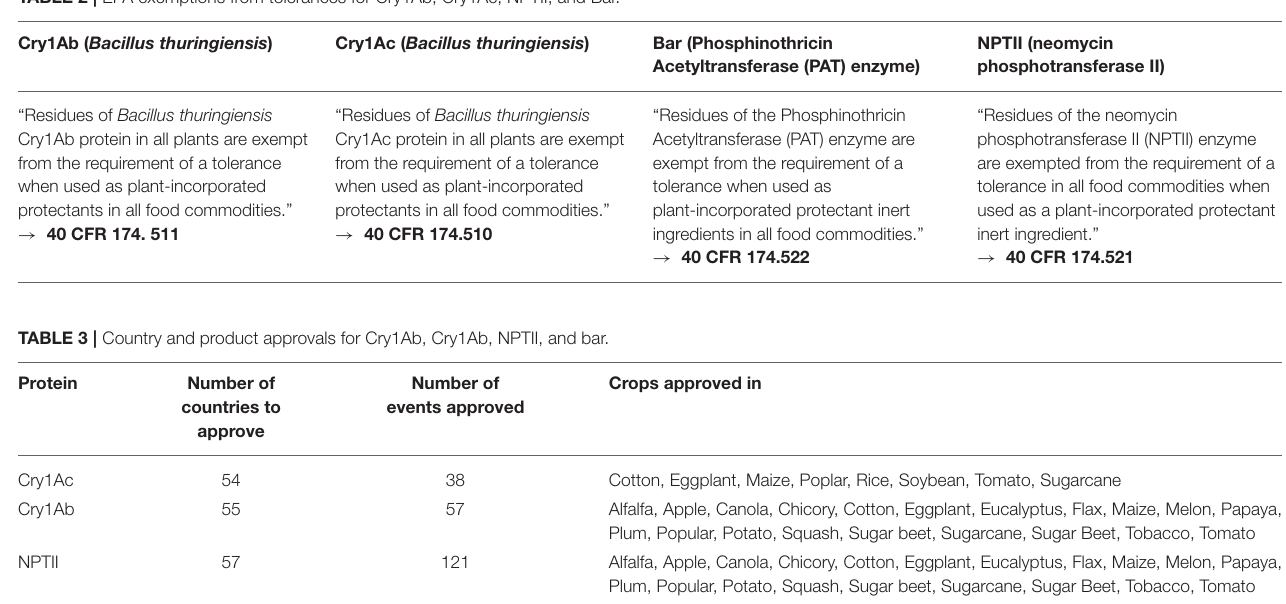
“Residues of Bacillus thuringiensis Cry1Ac protein in all plants are exempt from the requirement of a tolerance when used as plant-incorporated protectants in all food commodities.” → 40 CFR 174.510